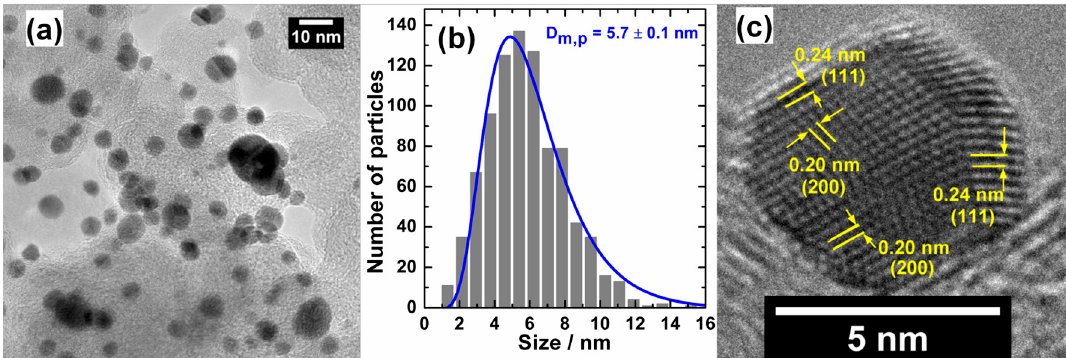
Figure 12. ( a ) Typical transmission electron microscopy (TEM) image of Au/C synthesized from the bromide anion exchange (BAE) method; ( b ) The corresponding particle size distribution: histograms were fitted using the log ‐ normal function (blue curve); ( c ) Typical high resolution transmission electron microscopy (HRTEM) micrograph of Au/C monometallic nanomaterial [64]: the zone axis